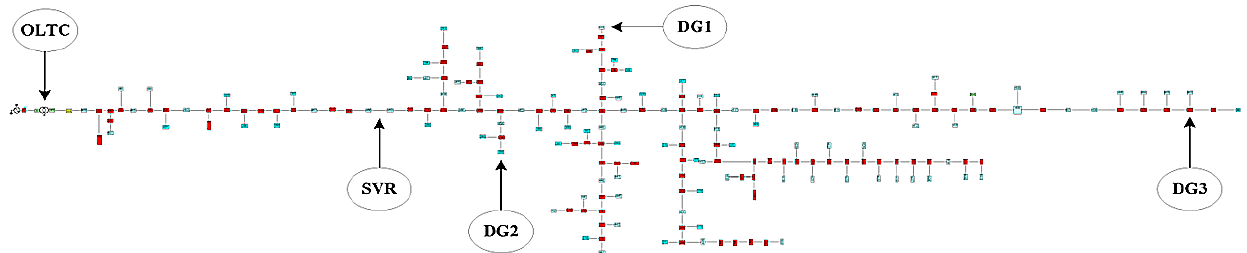
Figure 7. Test distribution system.